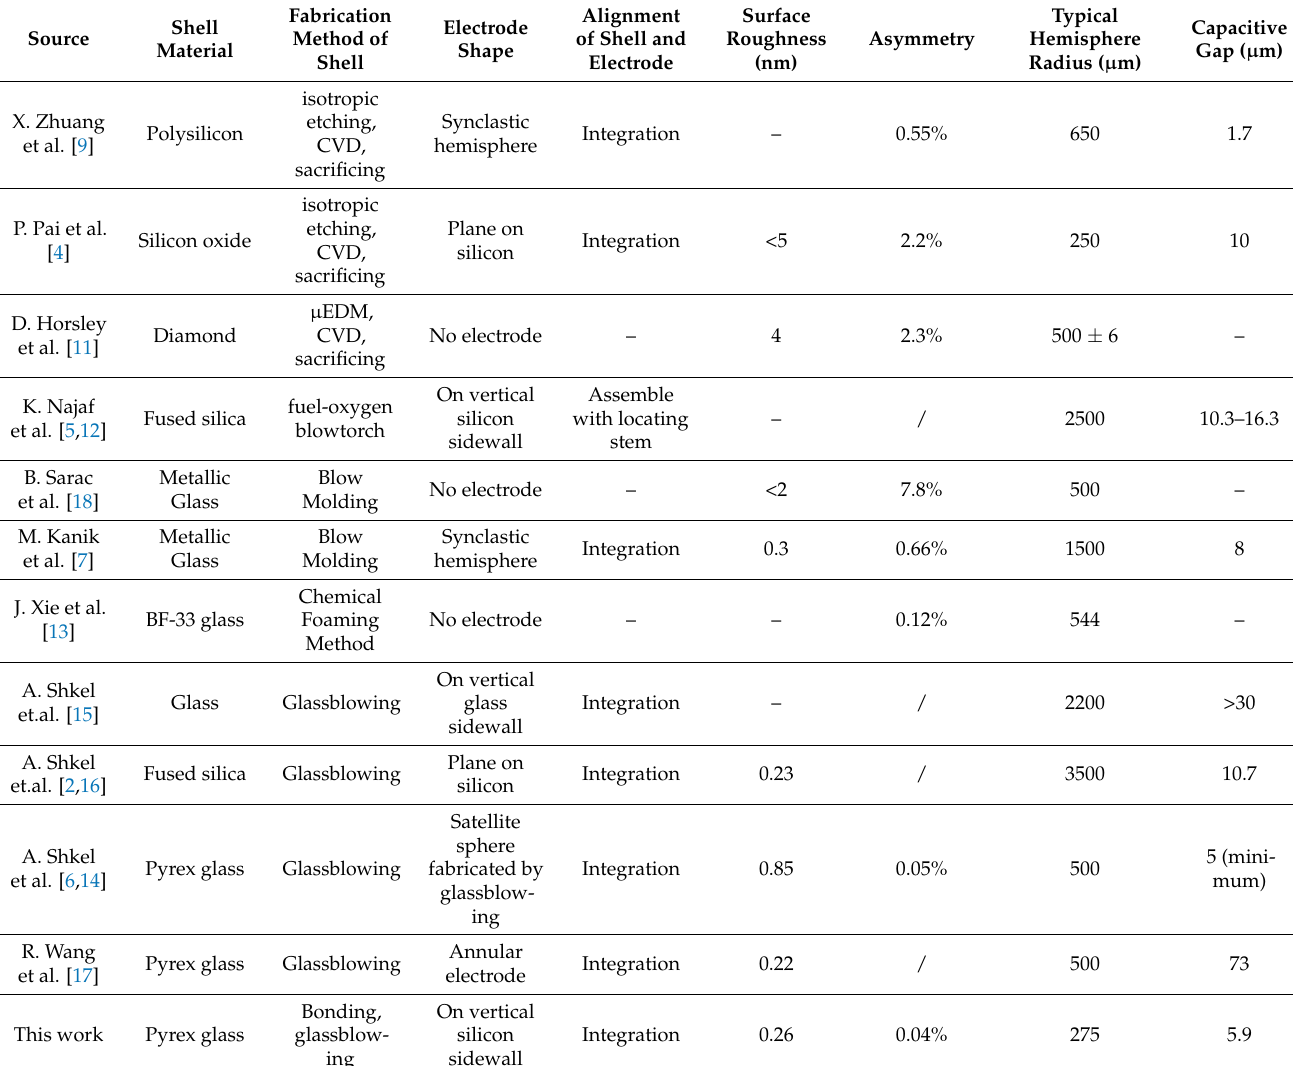
Figure 1. μ HR structure illustration.